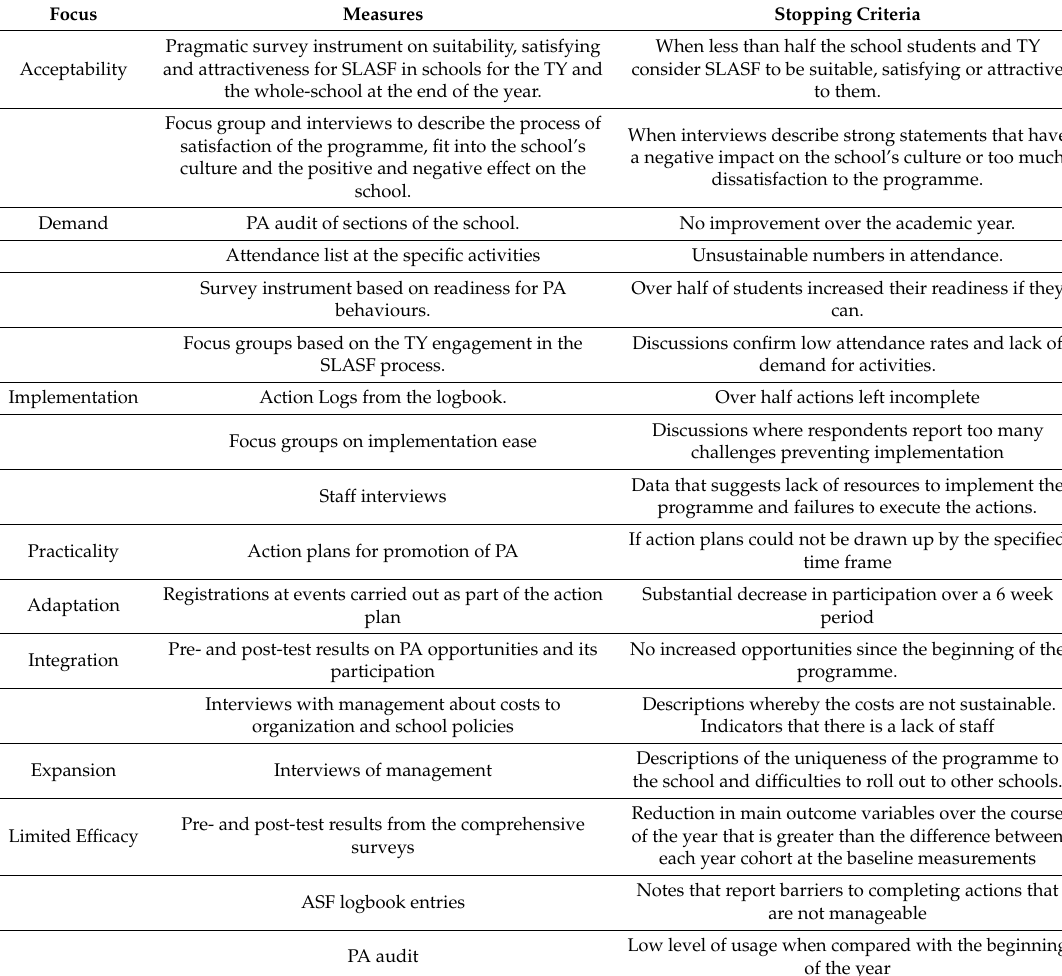
Table 1. Areas of focus for feasibility studies with measures and stopping